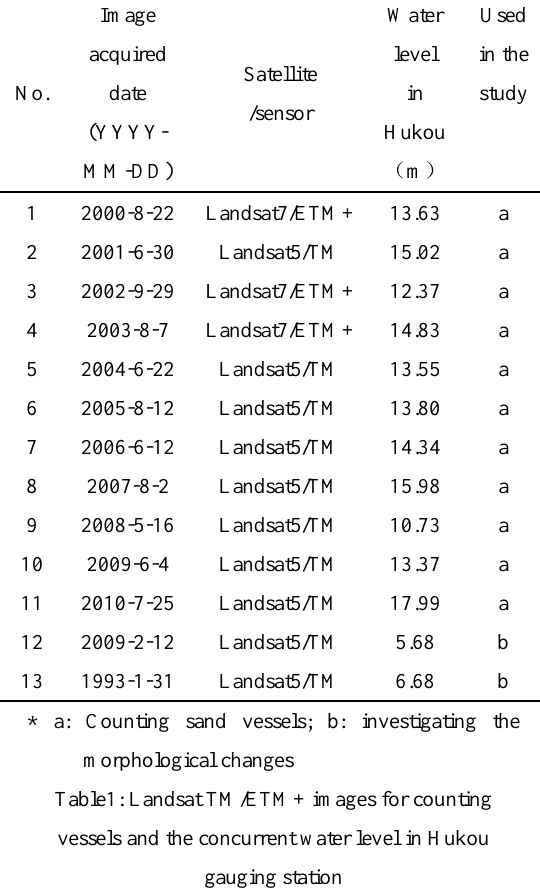
Table1: Landsat TM/ETM+ images for counting vessels and the concurrent water level in Hukou gauging